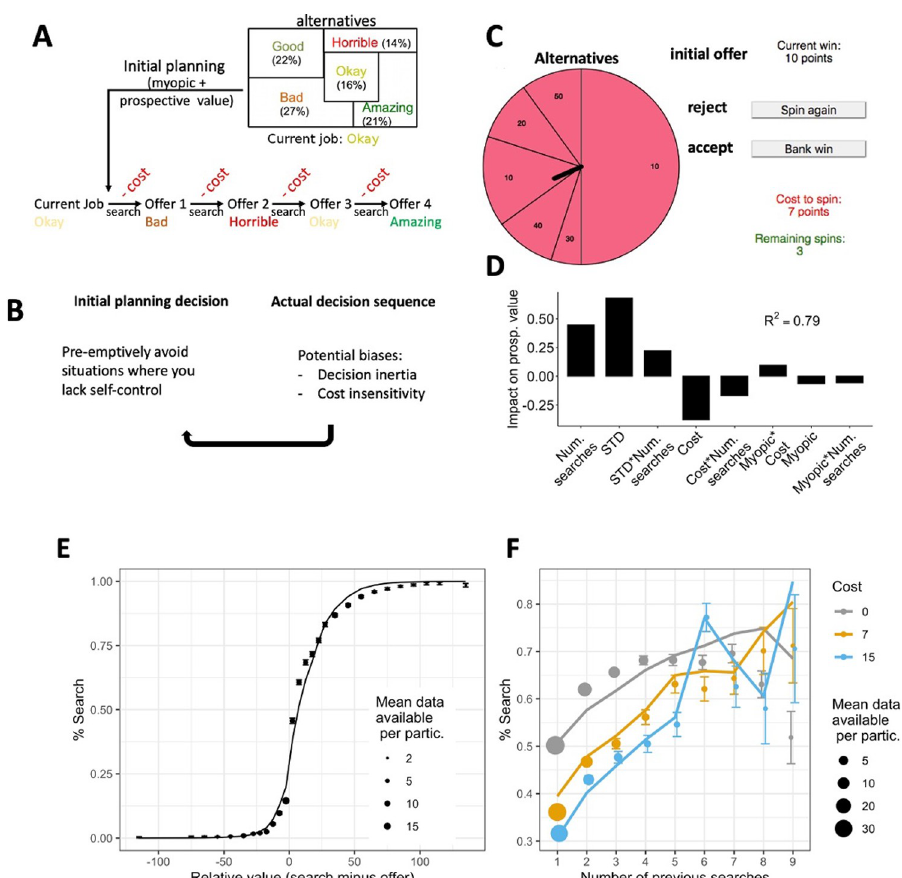
Fig 1. Sequential search paradigm. (Ai) Deciding whether to leave a job can be seen as a sequential search problem in which one repeatedly encounters alternative job offers, one at a time, that one can then either accept or instead reject in order to search for another alternative from the job market. In short, the decision-maker needs to weigh up the value of the current offer with the value of the job market. The job market’s value has 2 important components. First, it consists of the average (“myopic value”) value of the alternatives in the job market [14]. Second, it consists of its “prospective value,” i.e., the value that stems from the possibility to make sequences of searches within this pool of alternatives [14]. Taking prospective value into account means that the value of the alternatives is higher than might initial be thought on the basis of the average, myopic value. The degree to which this is the case depends on how many opportunities one has to explore the alternatives and the cost of doing this (see S1 Text “Decision tree model to derive prospective value” for more details). In the illustrated sequence, searches were continued until a sufficiently good alternative was encountered (one has found one’s “dream job”). Instead, if the opportunities for exploring are limited (i.e., only a limited number of searches are available), searches might have to stop when the available opportunities to search are depleted, before a “dream job” was found. (B) Sequential decisions can be broken down into 2 stages. The first is the initial consideration of the environment and its potential outcomes. Second, the agent goes through the actual sequence of searches. Here, biases of insensitivity to search cost or decision inertia can emerge. If agents are aware of these biases, they can be preemptively avoided by not engaging with sequences in the first place especially if the potential sequence is of the type in which one may be more prone to the biases or in which the biases may be more costly. (C) Illustration of the actual task screen participants saw. The wheel of fortune shows all possible alternatives and the sizes of the areas represent their probabilities of being drawn. Participants can accept the initial offer or any later offer by clicking “bank win” or search for an alternative by deciding to “spin again” that will reduce the number of “remaining spins” by one and cost as many points as show as “cost to spin.” (D) Prospective value is derived from a decision tree model (see S1 Text). This model captures the way in which prospective value is higher in environments with many available searches (num. searches), higher variability in how good and likely the offers are (STD), particularly if many searches are available (STD � Num. searches) and low cost, again particularly if many searches are available. Results are regression weights relating prospective value to different features of the environment (see Methods). The proportion of variance of prospective value explained by the regressors (R 2 ) was 79%. (E) Participants’ behaviour (confirmation sample—same results were found in the discovery sample) and model predictions for decisions after the initial planning stage: The higher the relative value favouring searching versus accepting the offer, the more likely participants were to search (dots with error bars). The model’s behaviour matches participants’